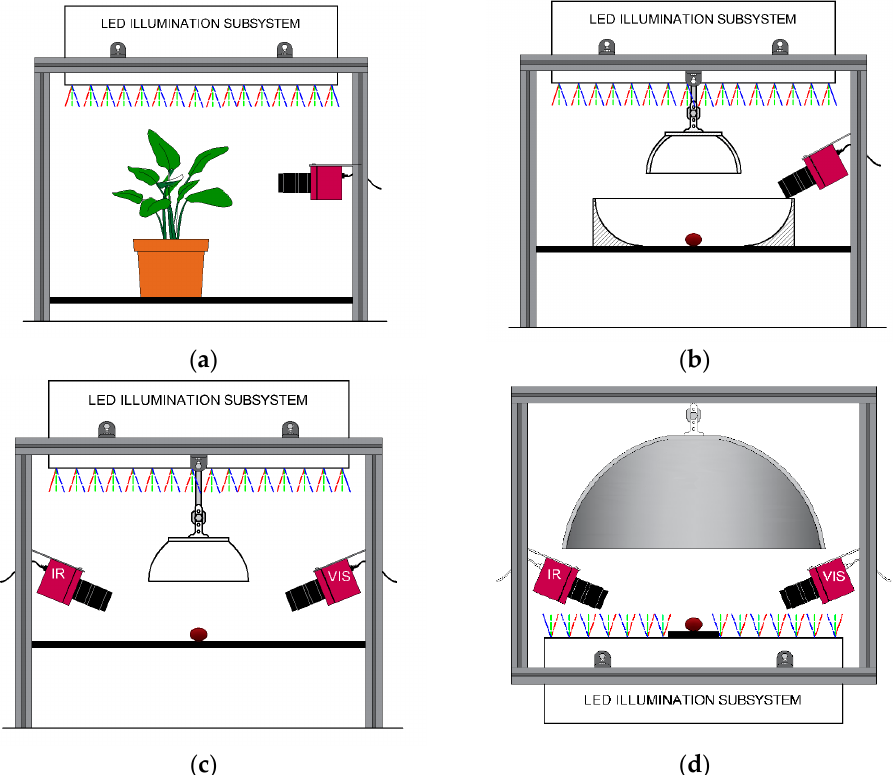
Figure 2. Flexible and reconfigurable dark chamber: ( a ) multispectral image (MSI) capture for growth analysis in plants, ( b ) configuration for suppression of unwanted reflexion and shadows from the illumination subsystem, ( c ) simultaneous visible and IR image acquisition with direct illumination and ( d ) back ‐ illumination for the simultaneous visible and IR imaging capture.